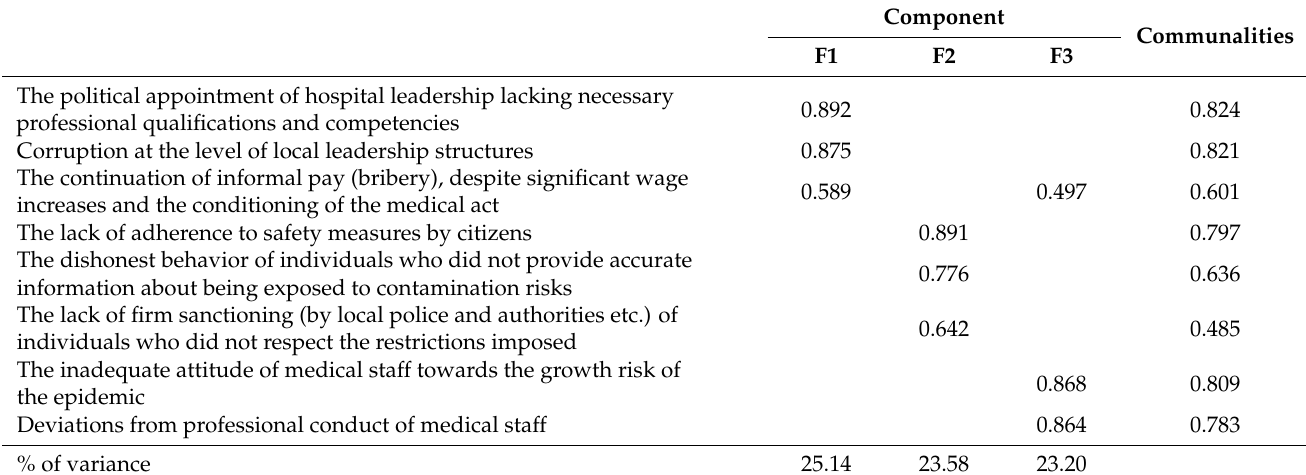
Table 1. Factor Analysis Table for the public perception of causes that contributed to the appearance of the crisis in Suceava County; Rotated Component Matrix a .